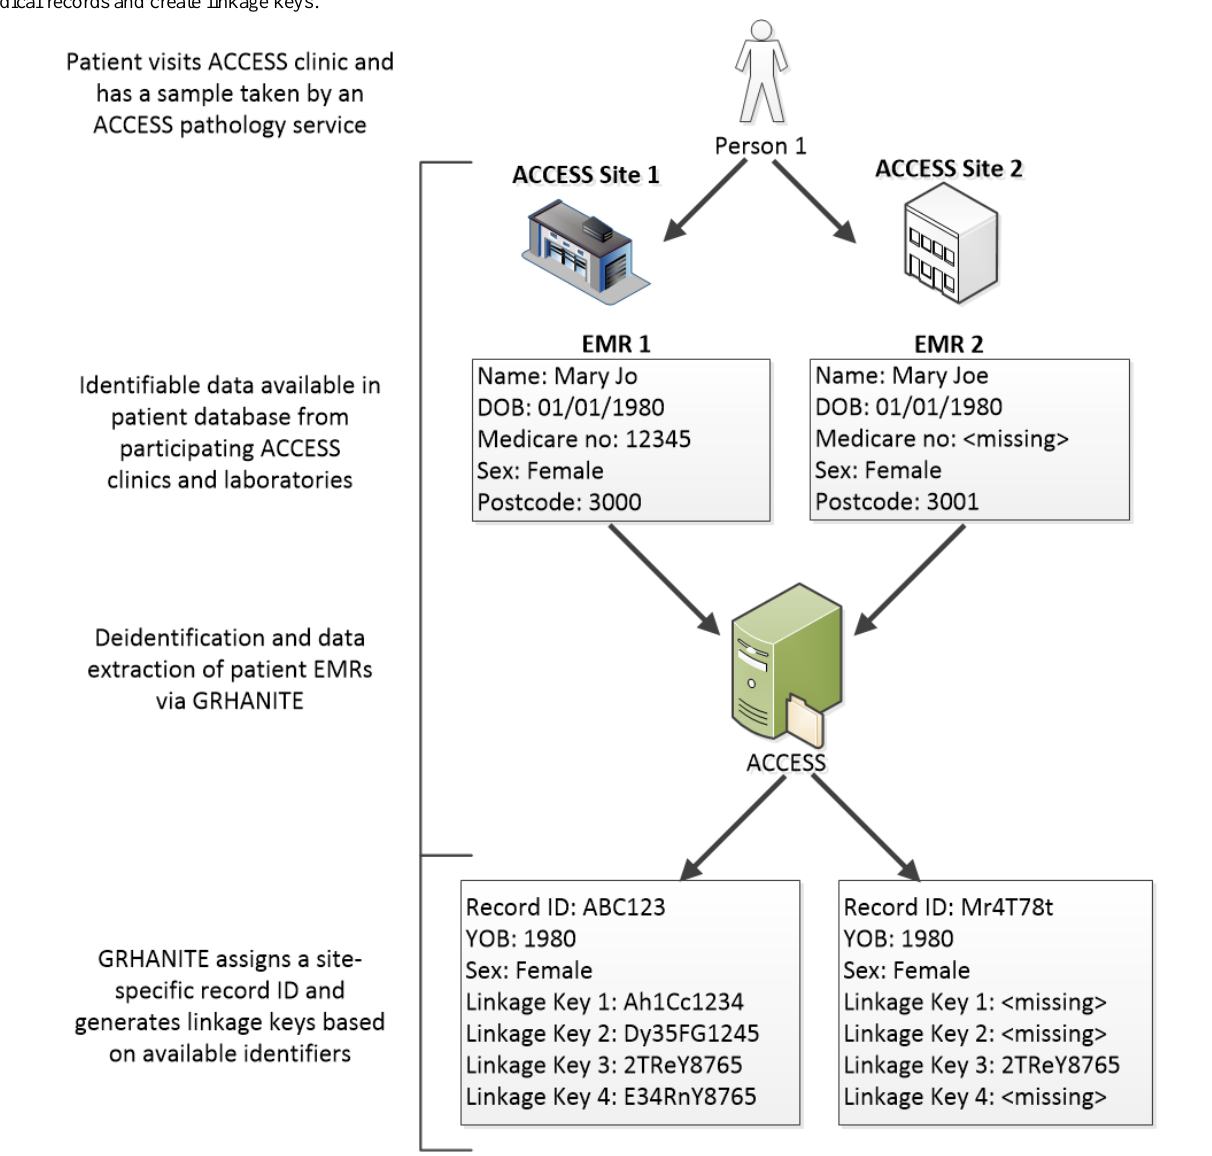
Figure 1. Data extraction in the Australian Collaboration for Coordinated Enhanced Sentinel Surveillance: using GRHANITE to deidentify electronic medical records and create linkage